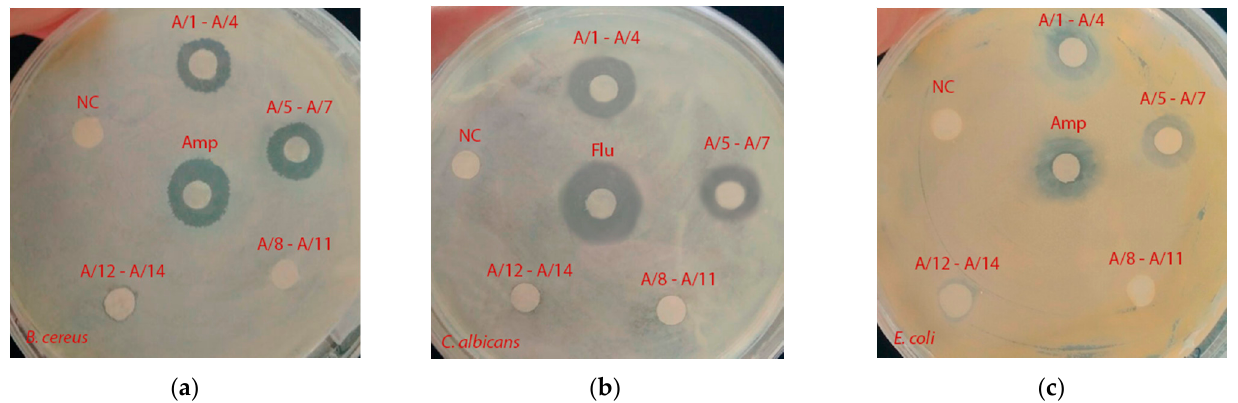
Figure 2. The evaluation of the antimicrobial properties of isolated fractions: ( a ) B. cereus ; ( b ) E. coli and ( c ) C. albicans .